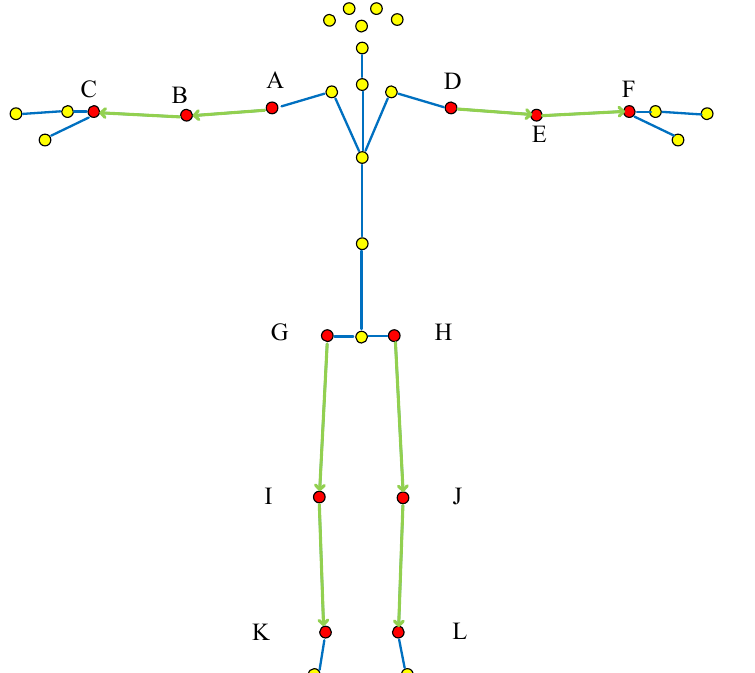
Figure 3. Overall “adjacent joint method” vector selection (The red dots are the selected bone joint, and yellow dots are bone joint points that do not need to be selected; Green line with arrow is the selected bone joint vector, Blue line is the connecting line of bone joints; The letters correspond to Table 1 and Figure 1).